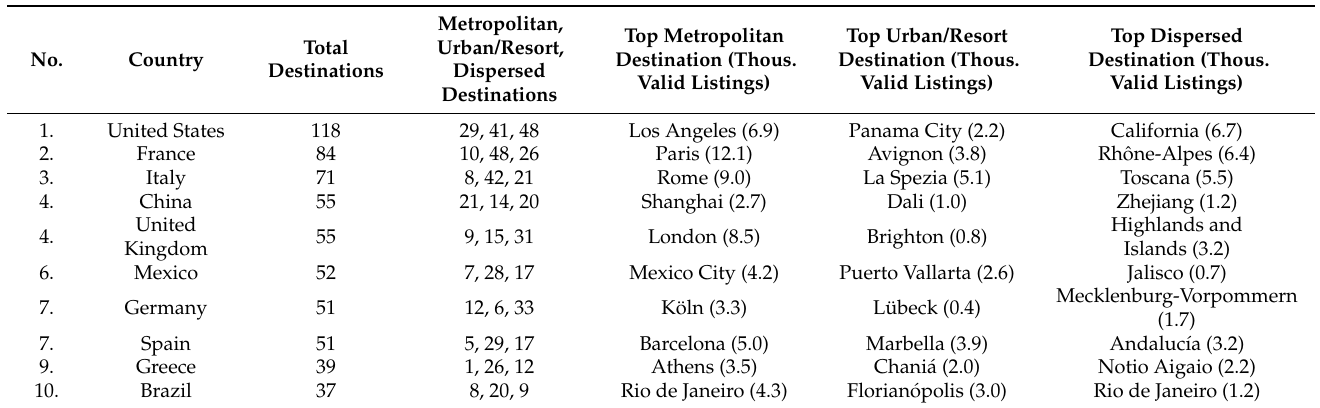
Table 3. Countries with the most